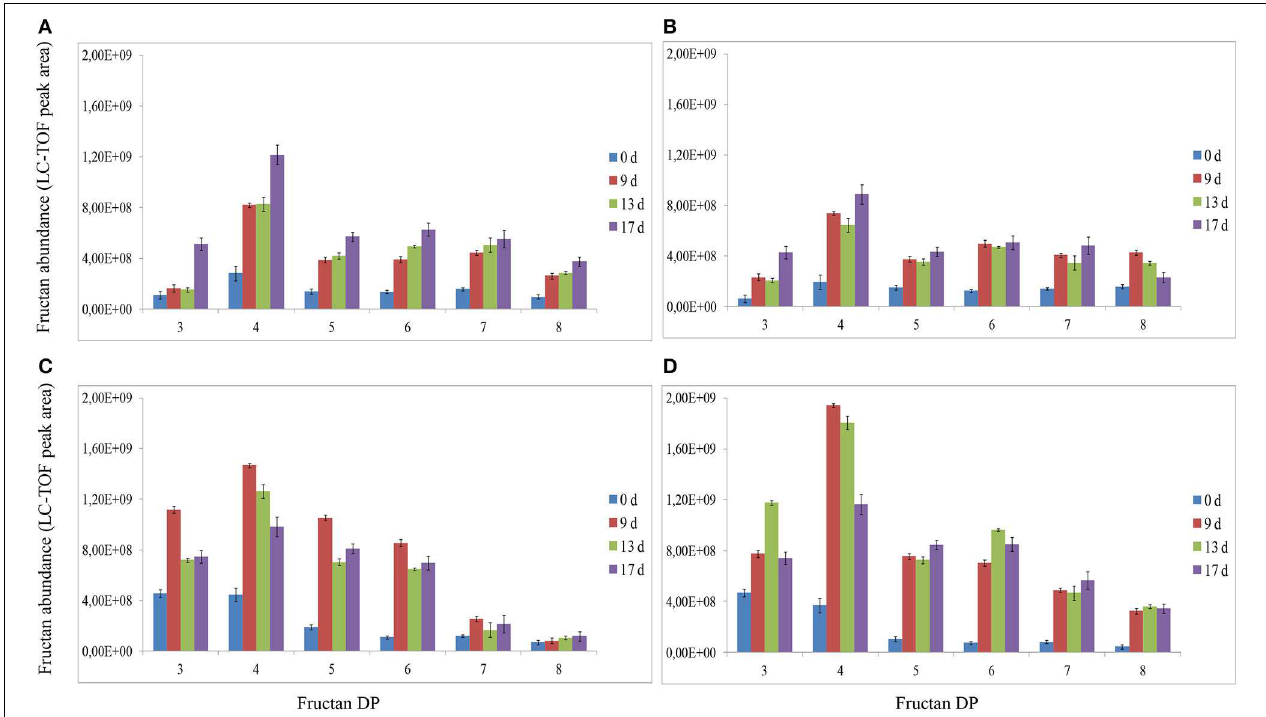
“Falster.” Fructan DP and composition on d 0, 9, 13, and 17 of cold acclimation are shown. Relative quantification of fructan oligosaccharides and polysaccharides was carried out using LC-ESI-TOF-MS. Data represent the mean ± SE, obtained from three biological replicates of the